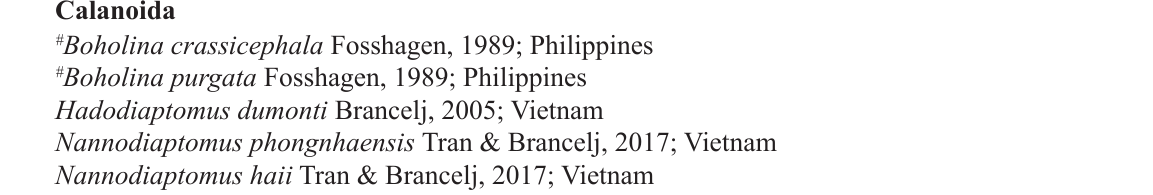
Table 2. Stygobiotic Copepoda recorded in Southeast Asia ( † = stygophile?; # = collected in anchialine